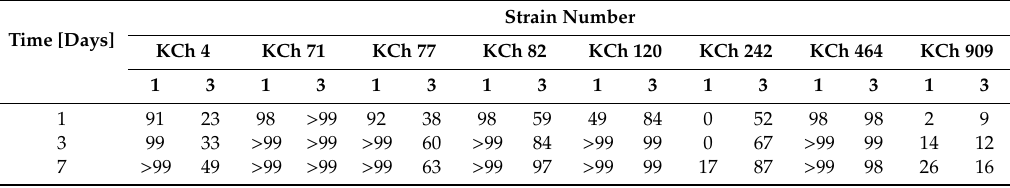
Table 3. Transformation of the substrate 3 by selected strains.